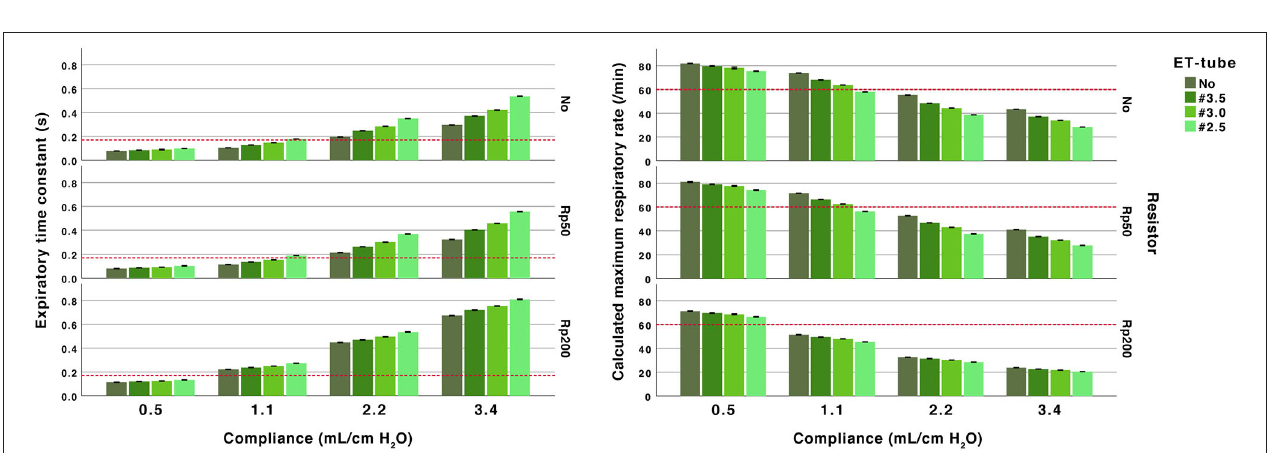
FIGURE 3 | Effect of airway resistance, endotracheal (ET) tube and compliance. Expiratory time constant (left) and calculated maximum ventilatory rate (right). All performed at PEEP 5 and peak inspiratory pressure of 20cm H 2 O at 10 L/min fresh gas flow. Arbitrary reference lines at τ rs 0.17s represent a complete expiration time of 0.5s (3* τ rs) and at a calculated maximum ventilatory rate of 60/min (fixed inflation time of 0.5s). The expiratory time constant increase with higher compliance and higher resistance (ET-tube, airway resistor or